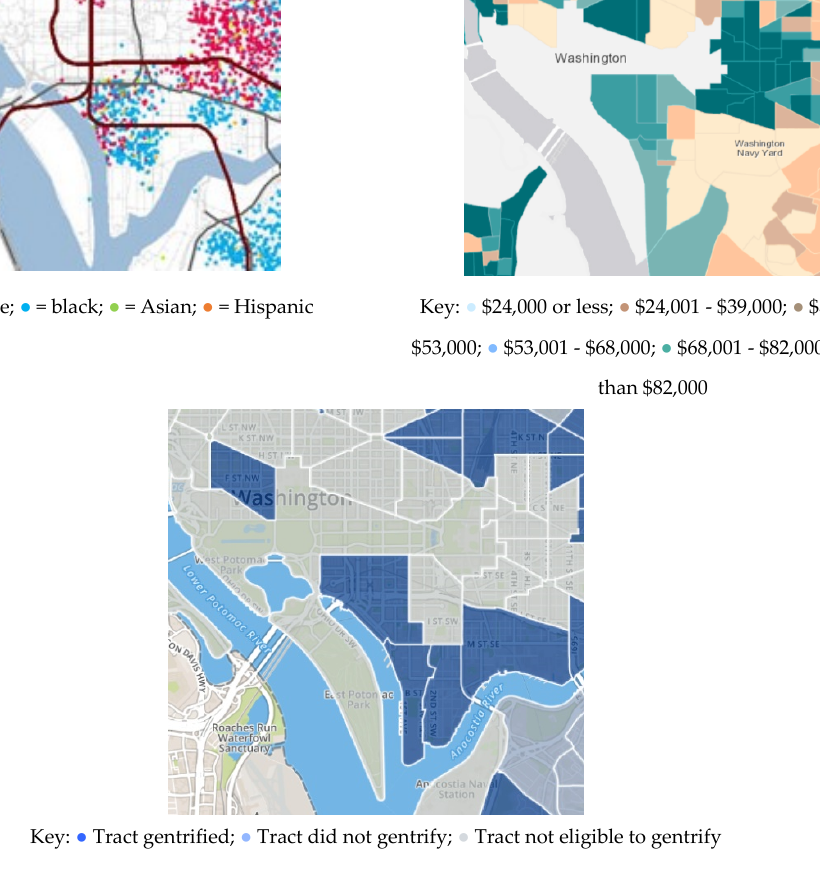
Figure 6. Detail from Figure 3, SW quadrant.